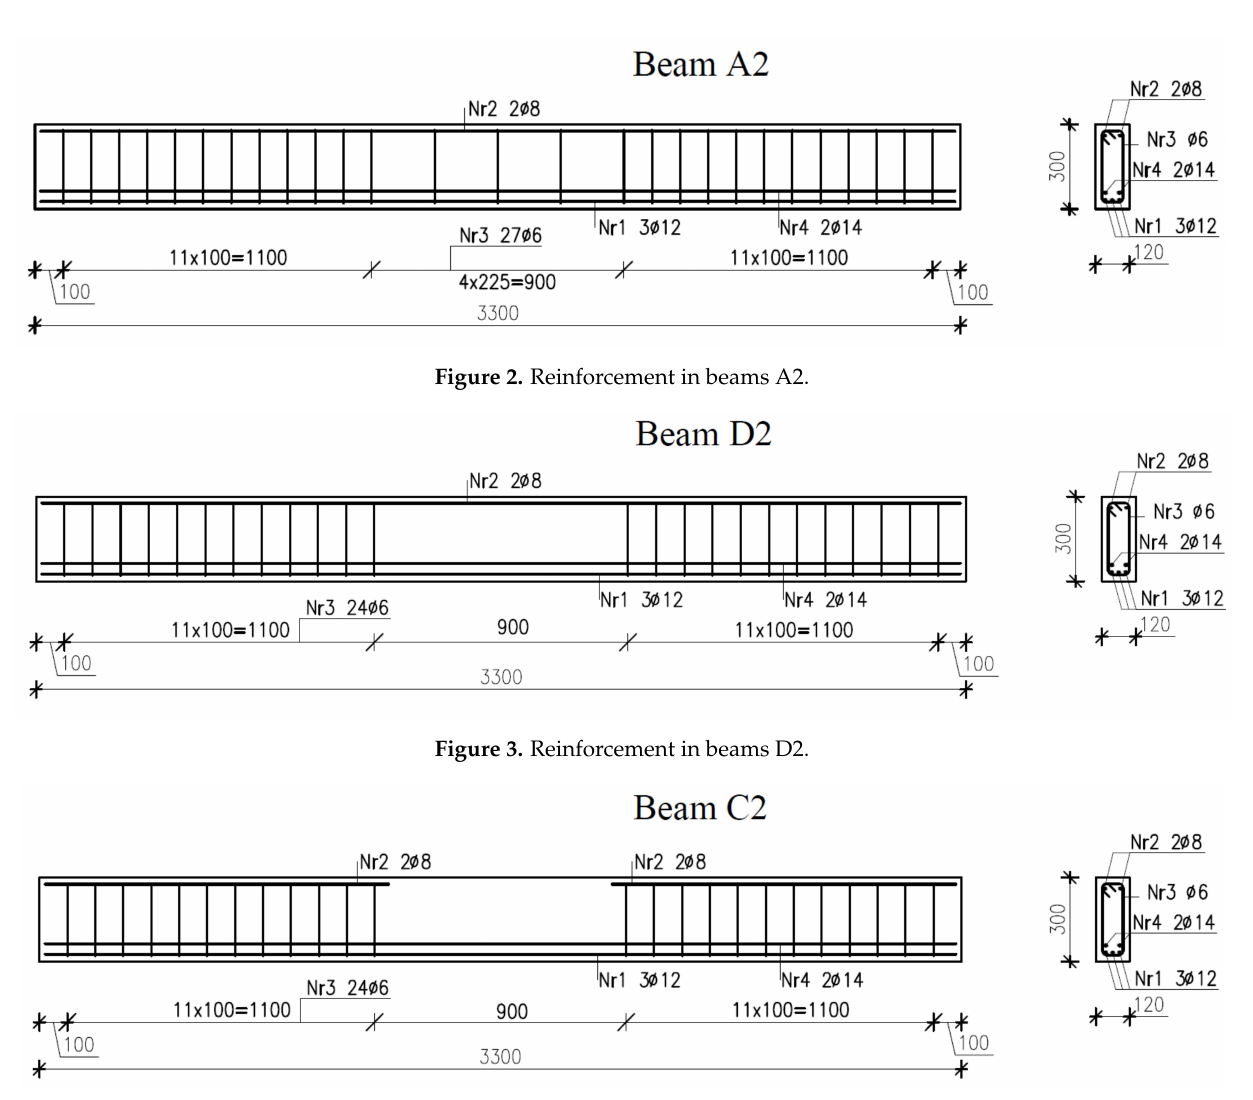
Figure 4. Reinforcement in beams C2.